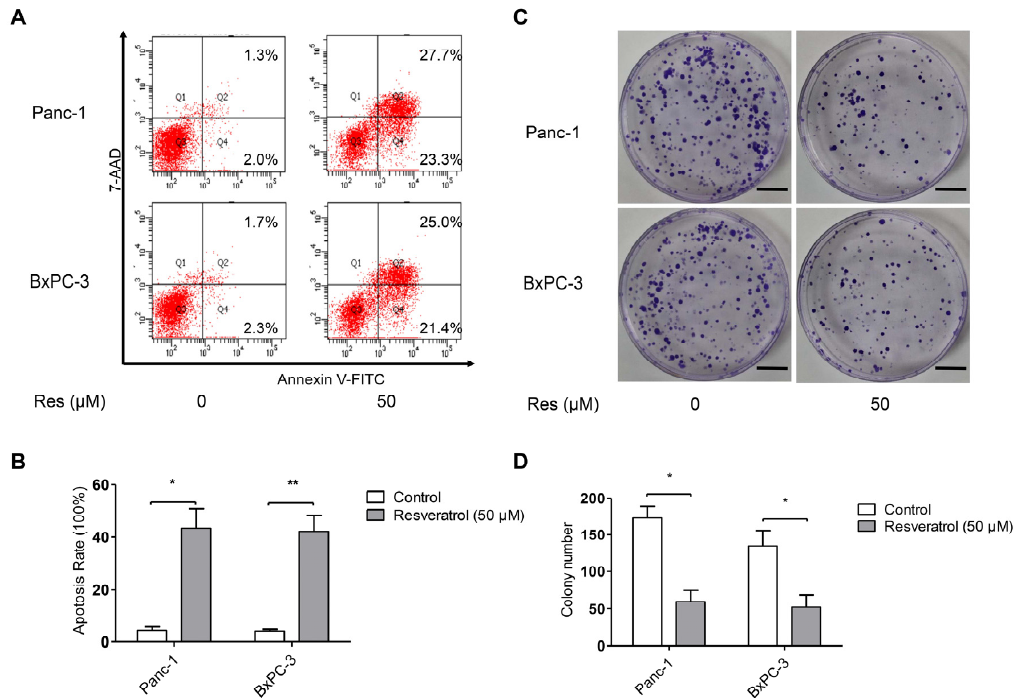
Figure 2. Resveratrol inhibits clone formation and induces apoptosis of pancreatic cancer cells. ( A , B ) The effects of resveratrol on Panc ‐ 1 and BxPC ‐ 3 cells apoptosis were detected by flow cytometry; ( C , D ) The effects of resveratrol on the colony ‐ forming ability of Panc ‐ 1 and BxPC ‐ 3 cells. Images are representative of three independent experiments (Scale bar: 1 cm). Column: Mean, bar: SD, * p < 0.05, ** p < 0.01.